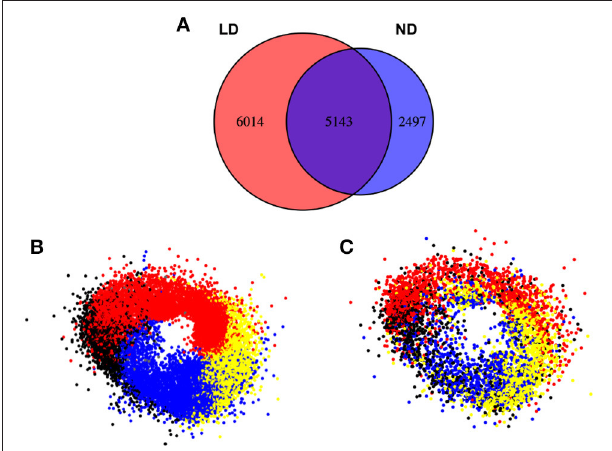
FIGURE 9 | The clustering of the clock-regulated genes does not change substantially between ND and LD conditions in Arabidopsis . (A) Venn diagrams representing genes in LD (red) and ND (blue) clusters. In LD conditions a higher percentage of genes (41%) follow a circadian expression than in ND (33%). Most genes identified as circadian in ND conditions (7640) exhibit circadian patterns also in LD (5143, 76%). Nevertheless, new genes are identified as circadian in LD (6014, 55%) indicating a higher circadian dependence in LD. (B) In the gene co-expression network composed of circadian genes in LD (11157), the same ring-like structure as in ND conditions is observed. This is constituted by the sequential distribution of the clusters constituted by genes peaking at Dawn (red), Day (yellow), Dusk (blue), and Night (black). (C) In the representation of the clusters obtained in ND conditions intersecting with the gene co-expression network in LD conditions (deep purple, 5143 genes), an apparent conservation of the circadian pattern is